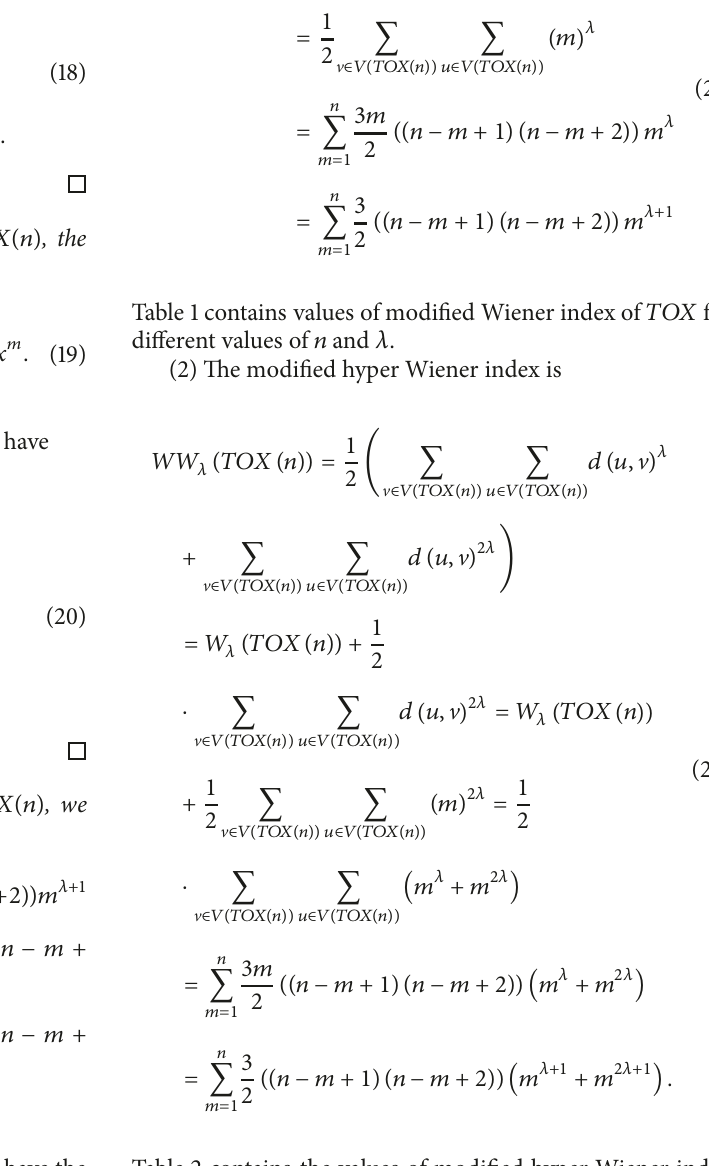
Table 2 contains the values of modified hyper Wiener index of 𝑇𝑂𝑋 for different values of 𝑛 and 𝜆